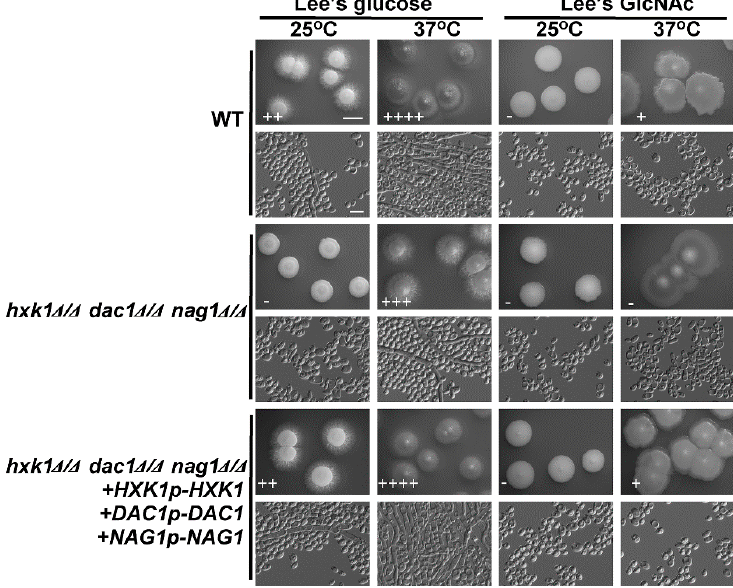
Figure 5. HXK1 , DAC1 , and NAG1 deletion led to a marked drop in C. tropicalis filamentous growth. WT, hxk1 Δ / Δ dac1 Δ / Δ nag1 Δ / Δ triple deletion mutant, and hxk1 Δ / Δ dac1 Δ / Δ nag1 Δ / Δ + HXK1p-HXK1 + DAC1p - DAC1 + NAG1p - NAG1 reconstituted strain cells were plated on Lee’s agar plates containing glucose or GlcNAc, and after 6 days at 25 °C or 37 °C representative colony and cellular morphology was assessed. Five individual transformants for each gene were used for filamentous growth assays. The degree of hyphal growth is represented by “+” signs, with the percentages of filamentous cells being indicated as follows: +, 0.1%–5%; ++, 5%–20%; +++, 20%–40%; ++++, 40%–60%. If no hyphal growth was evident, “ - “ was instead used to indicate cells (< 0.1%). Scale bars for colonies and cells were 2 mm and 10 μ m, respectively.